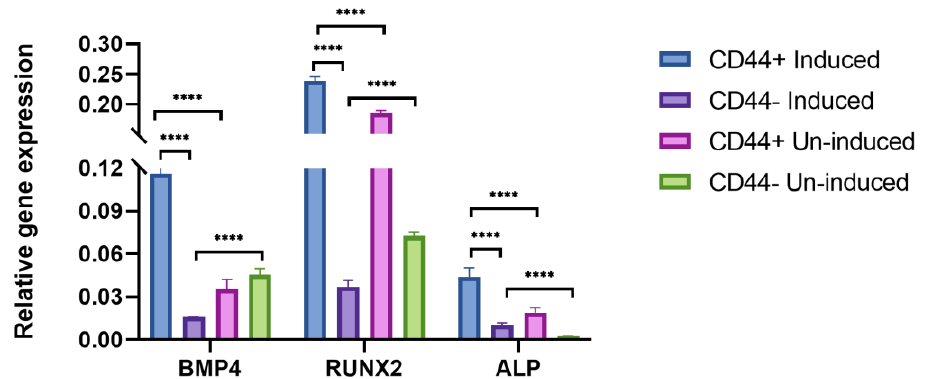
Figure 4. qPCR analysis of relative gene expression of osteogenic markers after 21 days of osteo-induction. BMP4, RUNX2, and ALP relative expression levels of CD44 + cells and CD44 − cells. Un-induced cells grown in a complete growth medium, and induced cells grown in the osteogenic − —CD44 negative cells, and **** p ≤ 0.0001. medium. CD44 + — CD44 positive cells, CD44 − — CD44 negative cells, and **** p ≤ 0 .0001. medium. CD44 + —CD44 positive cells, CD44